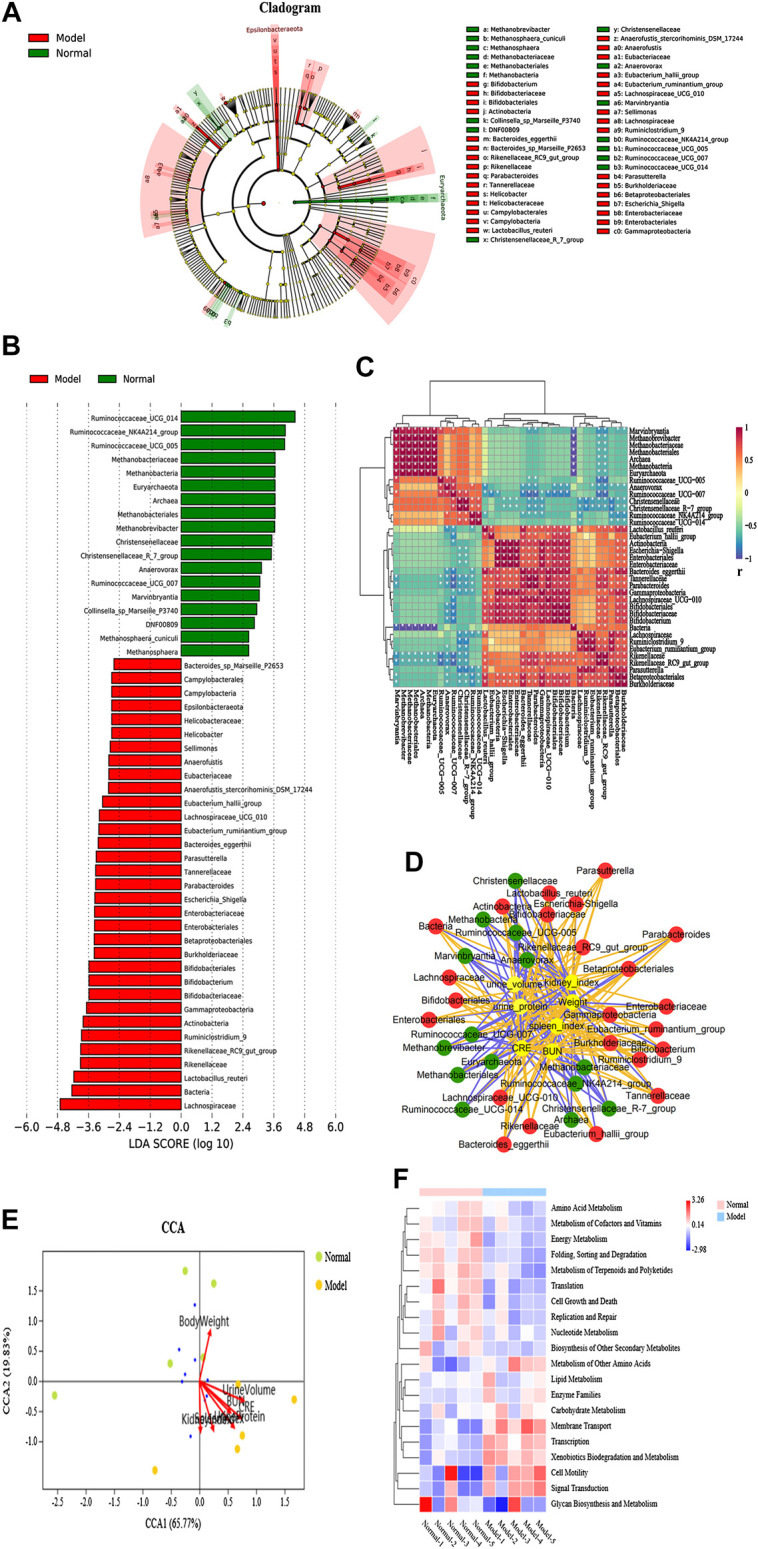
Specific fecal microbial communities and potential functional pathways in IgAN rats. (A) Cladogram displaying the specific bacterial taxa between the normal and model groups (phylum to genus level). (B) LEfSe analysis of the specific bacterial taxa of the normal and model groups (LDA score > 3.0, Wilcoxon rank-sum test p < 0.05, n = 5). (C) CCA analysis of biochemical parameters and microbial communities at the phylum level. The direction and length of the red lines indicates the contribution of the corresponding parameter to the microbial communities. (D) Interaction network diagram of the biochemical parameter and specific microbes, based on Pearson’s correlation analysis. The orange line represents a positive correlation, while the blue line represents a negative correlation. (E) Heatmap showing Pearson’s analysis of discriminant bacterial species in the normal and model groups. Significant differences were determined using Wilcoxon rank-sum test, *p < 0.05. (F) KEGG functional prediction analysis of altered microbial communities associated with IgAN rats.